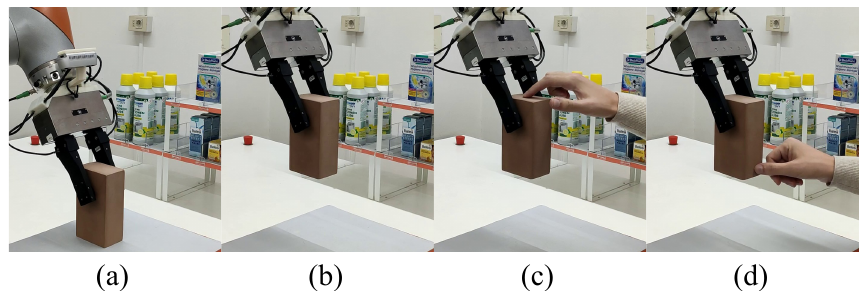
Figure 10. Snapshots of the first experiment: ( a ) grasp configuration; ( b ) after lifting; ( c , d ) disturbance applied by a human